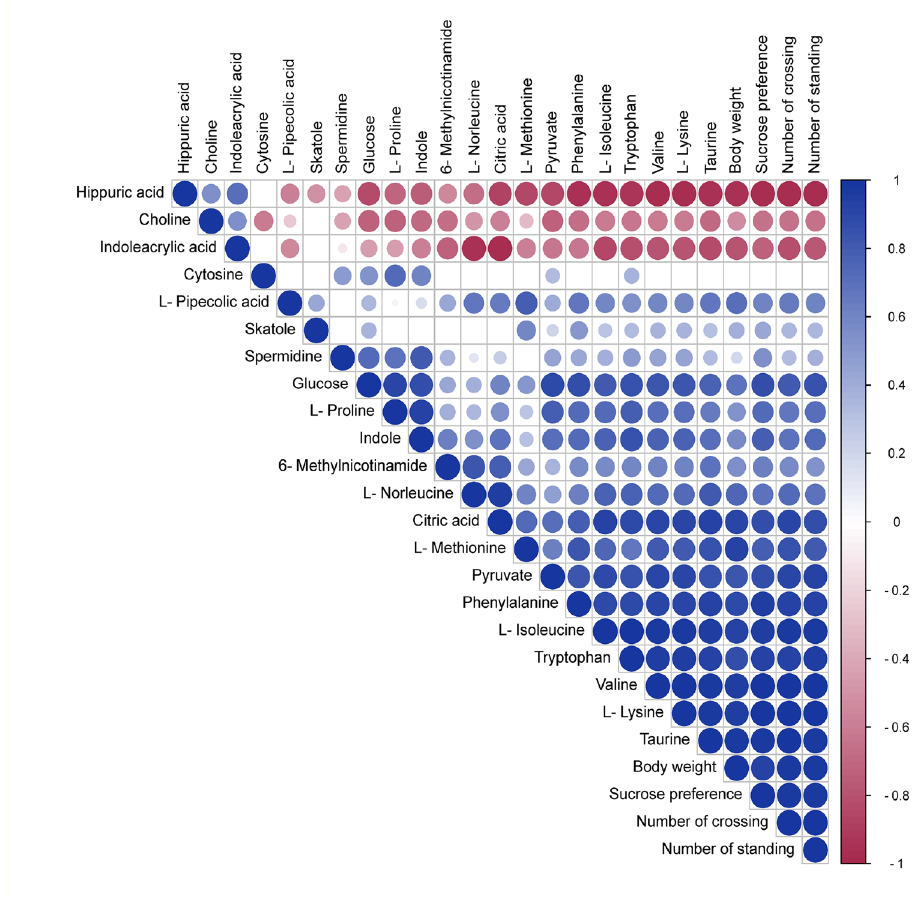
Figure 5. Heat map of the correlation between differential metabolites and behavioral indicators based on Spearman’s correlation